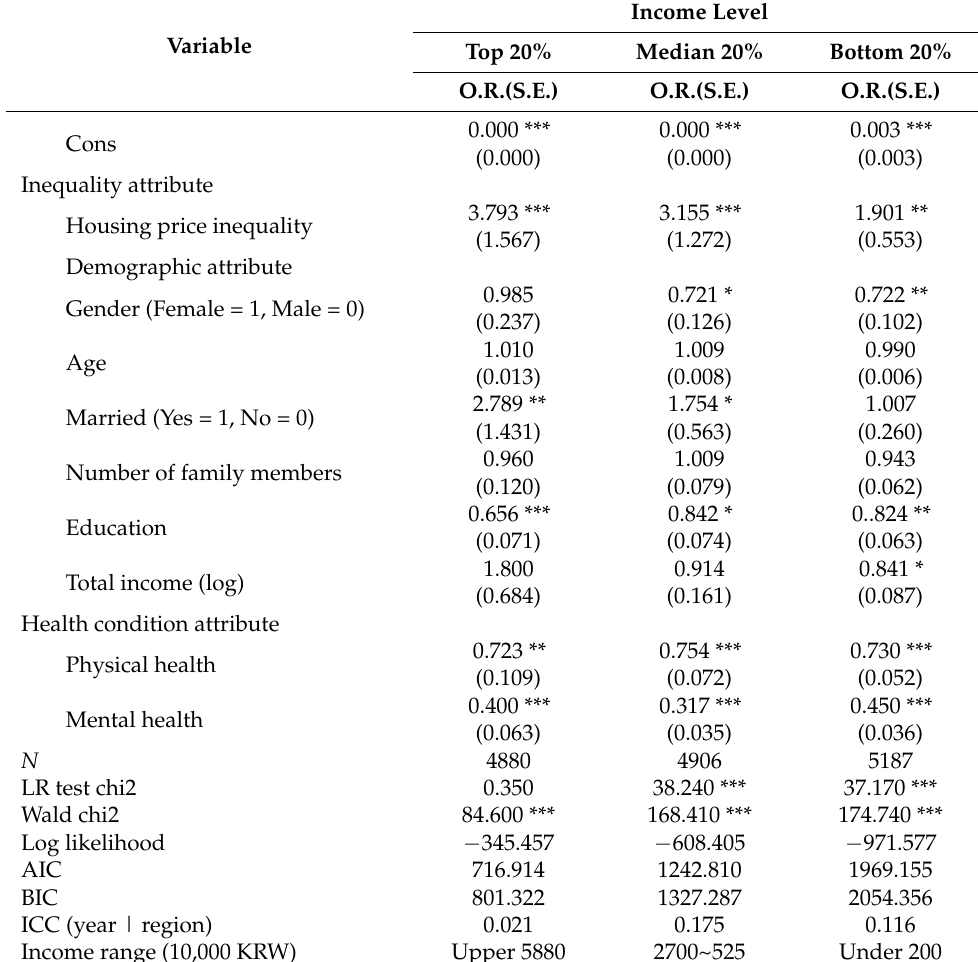
Table 3. Results for regression analysis by income percentiles.